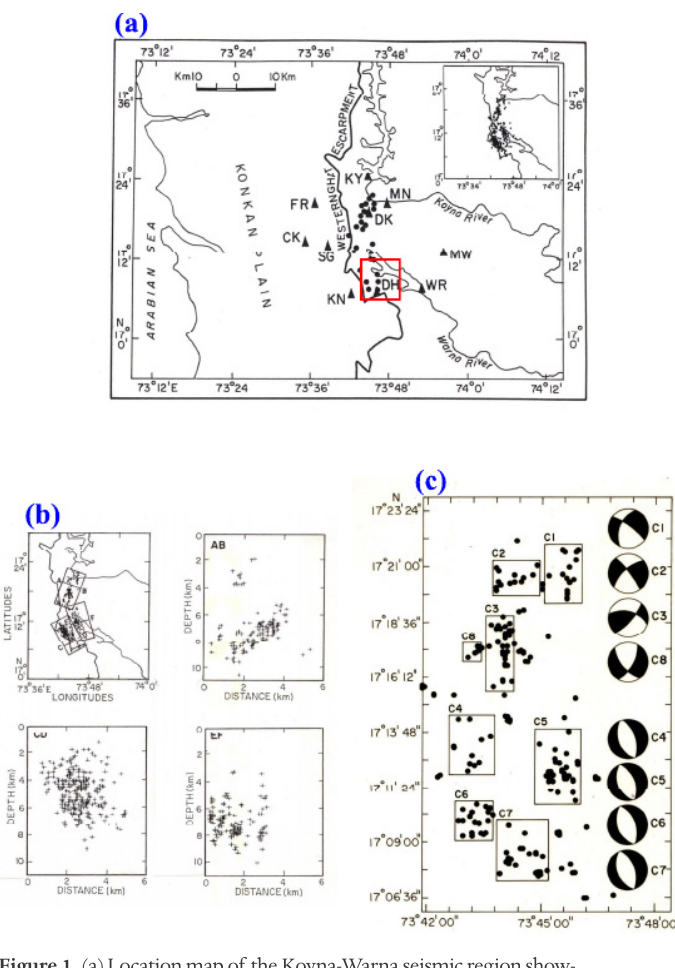
Figure 1. (a) Location map of the Koyna-Warna seismic region show- ing some of the seismograph stations (filled triangles) of the digital network operated, and the well located epicenters (filled circles) of the local earthquakes. The inset shows the observed seismicity pat- tern in the region described in the text. (b) Depth distribution of seis- micity along three sections AB, CD, and EF observed in the region. (Figures 1a and 1b, after Rai et al. [1999]). (c) Composite source mech- anism solutions for different earthquake clusters CI, C2, C3, and C8 in the Koyna, and C4, C5, C6, and C7 in the Warna seismic region (after Sharma